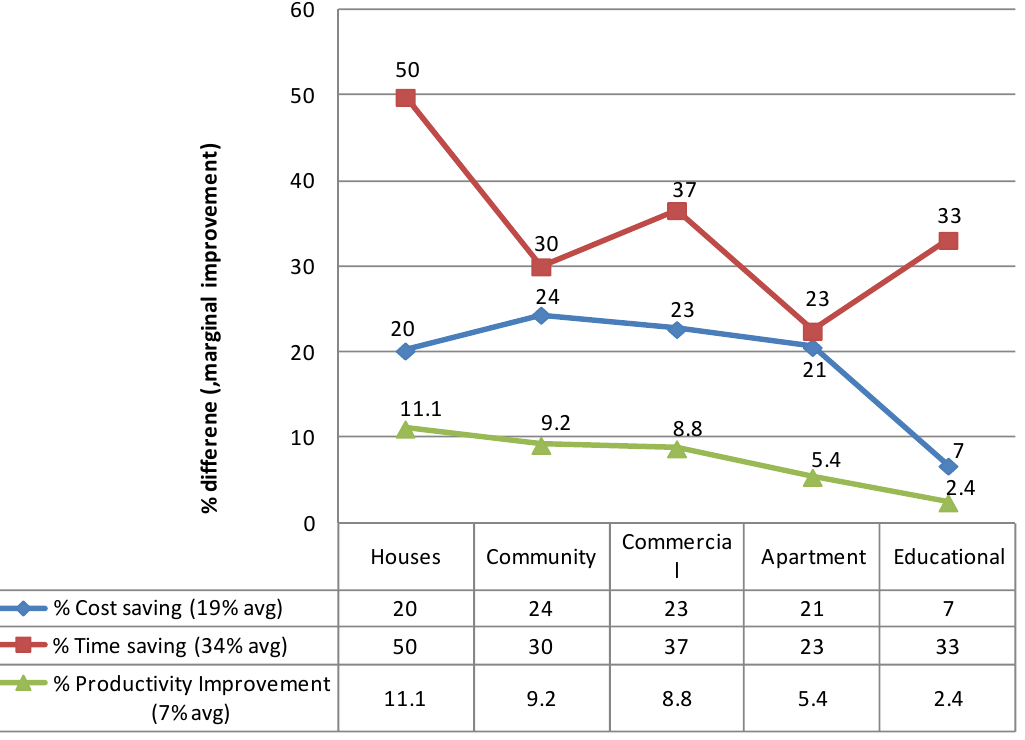
Figure 1. Time, cost and productivity improvement achieved by the use of prefab in